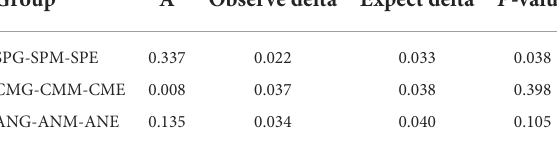
TABLE 3 Multi-response permutation procedure (MRPP) analysis of differences among groups. Group A Observe delta Expect delta P -value SPG-SPM-SPE